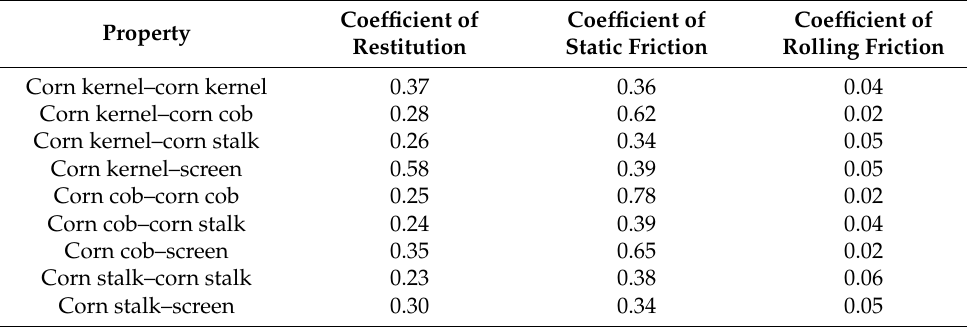
Table 7. The physical properties of characterizing contact between components.